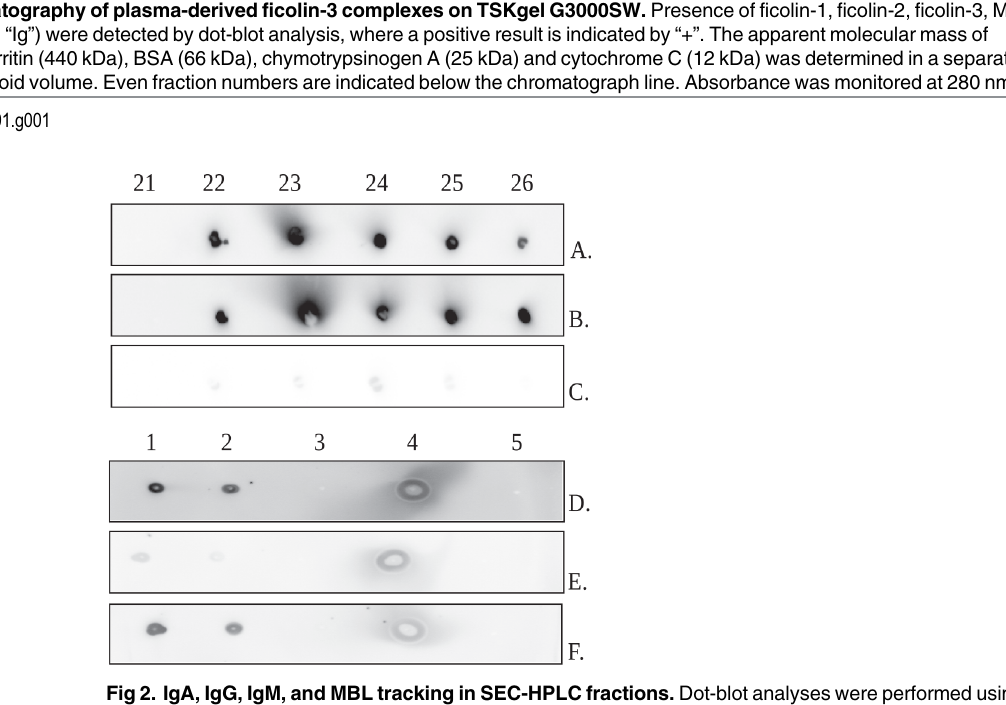
Fig 2. IgA, IgG, IgM, and MBL tracking in SEC-HPLC fractions. Dot-blot analyses were performed using (A) anti-ficolin-3 mAb; (B) anti-IgA α chain, IgG γ chain, IgM μ chain polyclonal Ab; and (C) anti-MBL mAb. Fractions 22 – 25 were eluted from the TSKgel G3000SW column (Fig 1) and concentrated 9-fold. IgA (D), IgG (E), and IgM (F) tracking in ficolin-3 complexes with dot-blotting. Samples: 1. Ficolin-3 preparation, concentrated eluate from G3000SW column (fractions 22 – 25); 2. 10-fold diluted ficolin-3 preparation; 3. 100-fold diluted ficolin-3 preparation; 4. Human plasma; 5. Recombinant ficolin-3.